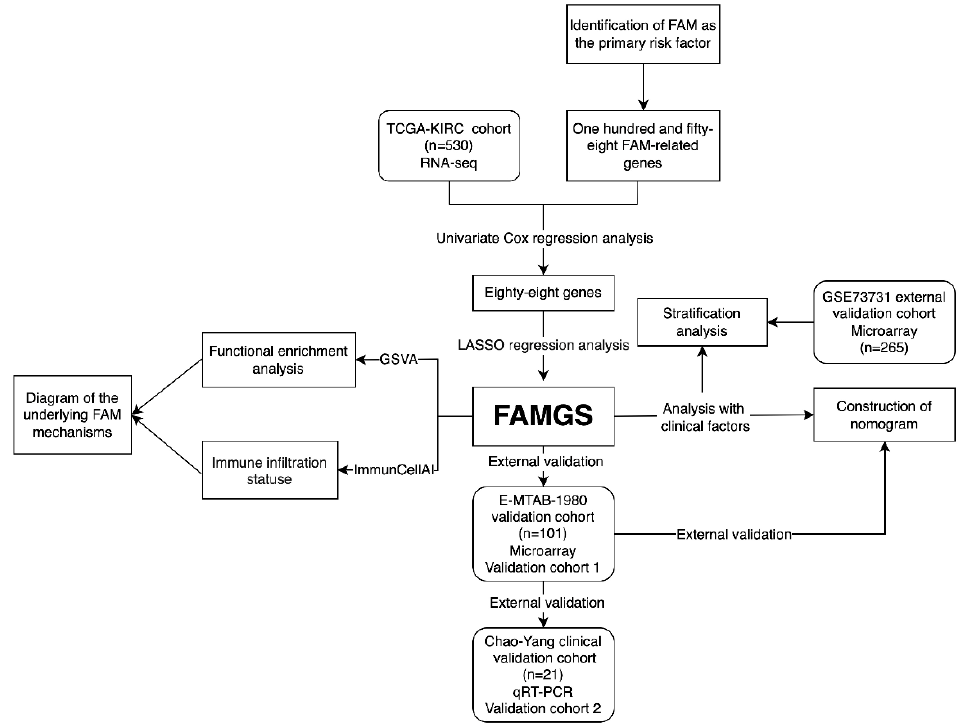
Figure 1. Flow diagram of study design. FAM: Fatty acid metabolism; TCGA: The Cancer Genome Atlas; KIRC: Kidney renal clear cell carcinoma; LASSO: Least absolute shrinkage and selection operator; FAMGS: Fatty acid metabolism gene signature; GSVA: Gene set variation analysis; ImmunCellAI: Immune cell abundance identifier; qRT-PCR: Real-time Quantitative Polymerase Chain Reaction.